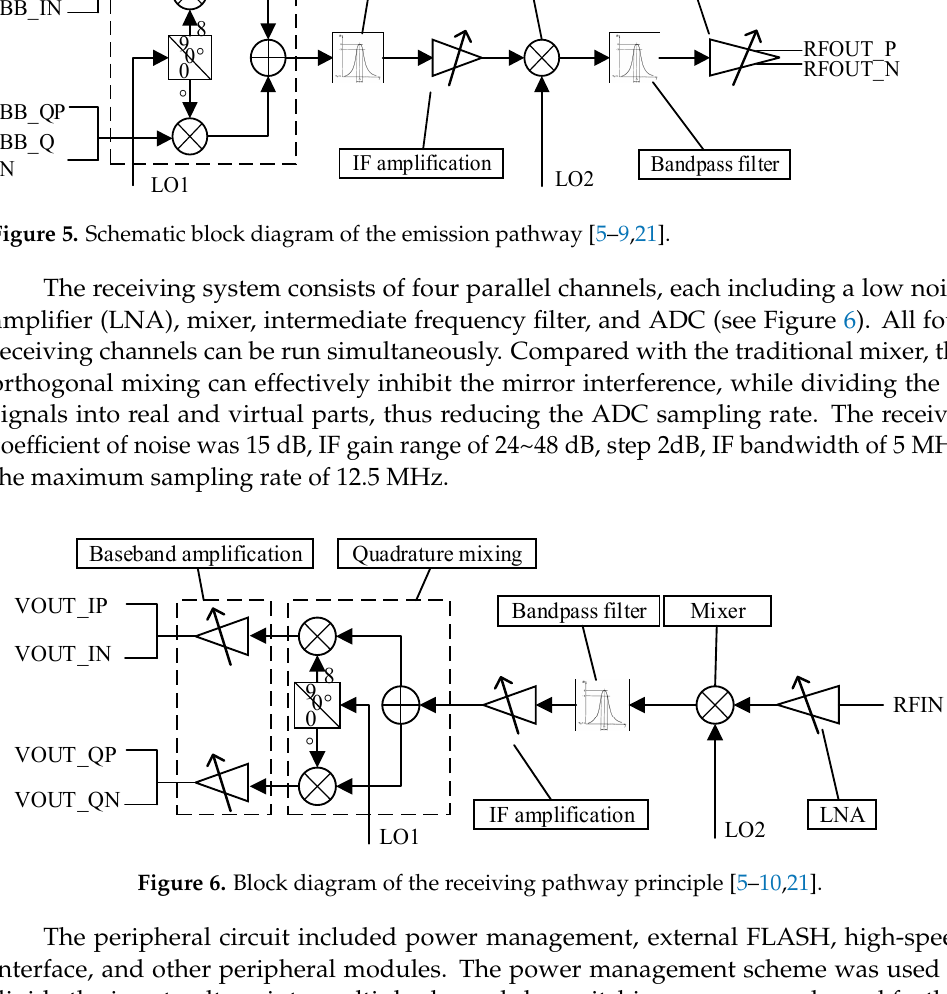
Figure 4. Antenna design [6–11].